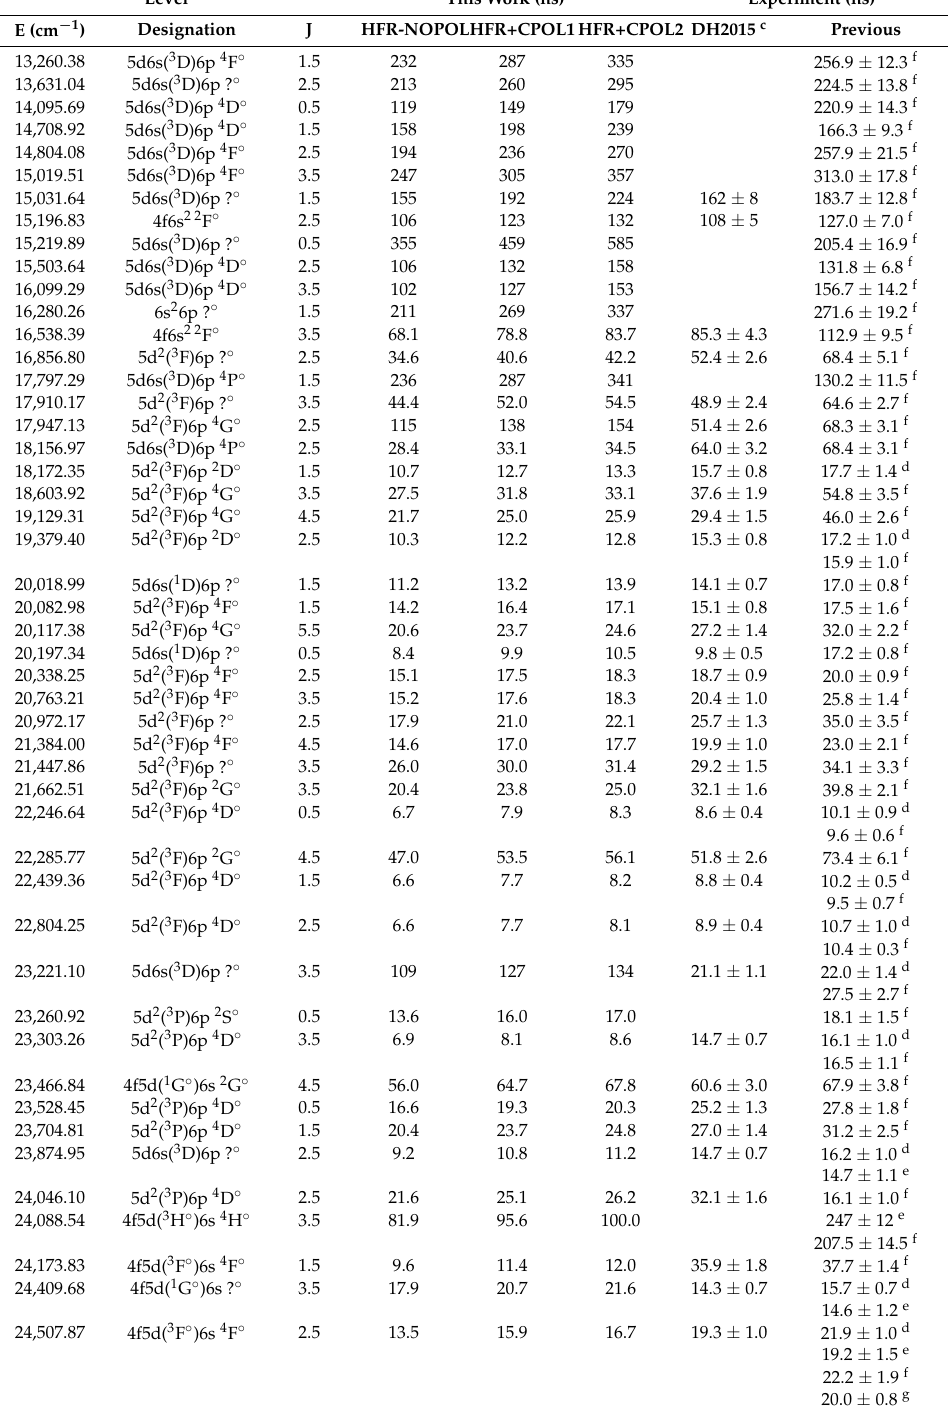
Table 1. Comparison of the radiative lifetimes computed in the present work using three different HFR models with the most recent available experimental values for odd-parity levels in La I. Level a This Work (ns) b Experiment